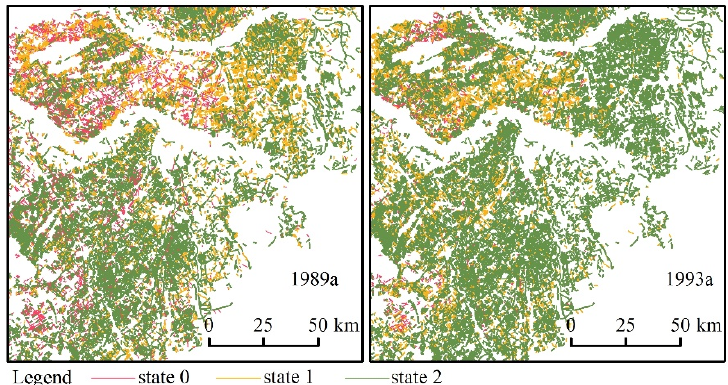
Figure 8. The predicted farmland shelterbelt states in 1989 and 1993.